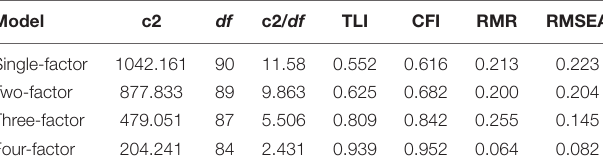
TABLE 1 | Confirmatory factor analysis results ( N = 214).